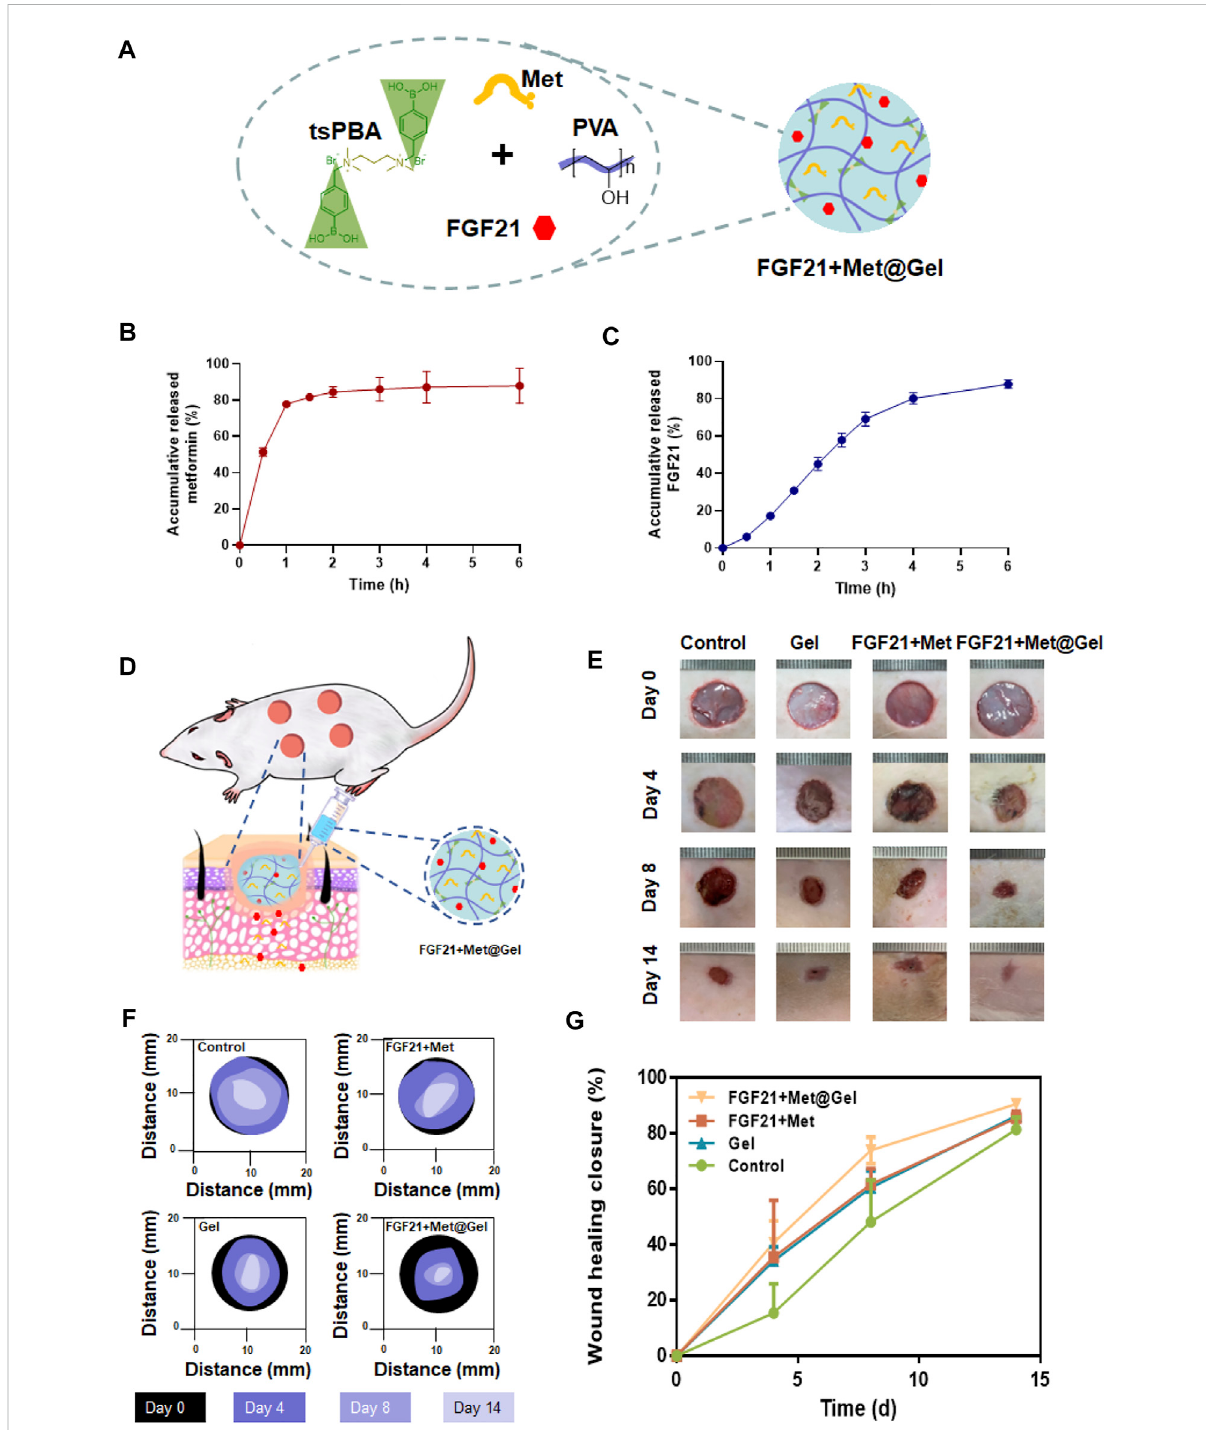
FIGURE 3 (A) . Schematic diagram of the drug-loaded PBA tsPBA (FGF21 + Met@Gel). (B) . Release of metformin from PBA tsPBA in vitro, n = 3. (C) . Release of FGF21 from PBA tsPBA in vitro , n = 4. (D) Representative pictures of the rat model. (E) Representative images of wounds at days 0, 4, 8, and 14 after differenttreatments. The unit of therulers in theimages equals to 1 mm. (F) Wound area tracing over 14 days ineach treatmentcategory. (G) Curves of the wound healing closure rate versus treatment time. The wound closure rate is represented as a percentage of the healed wound area to the initial wound